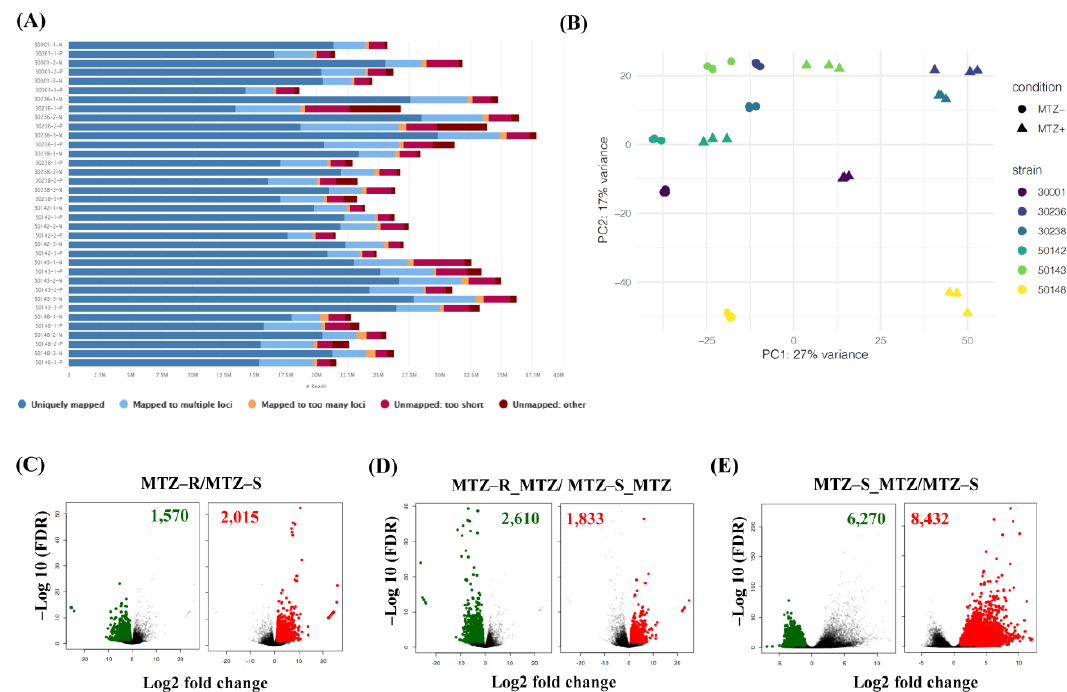
Figure 2. A global view of DEGs in the MTZ-R and MTZ-S transcriptomes treated with or without MTZ. ( A ) The reads generated from the RNA-seq data of six T. vaginalis isolates in the presence or absence of MTZ were mapped to the T. vaginalis reference genome, and the percentage of mapped reads was shown. ( B ) PCA of six isolates in the presence (MTZ+) or absence (MTZ-) of MTZ treatment. Biological triplicates of each sample were presented as different colors. Volcano plots showed the significantly differential gene expression (FDR < 0.05, log2 |fold change| = 1) in the MTZ-R transcriptomes compared with those of MTZ-S in the absence of MTZ (MTZ-R/MTZ-S) ( C ) or upon MTZ treatment (MTZ-R_MTZ/MTZ-S_MTZ) ( D ). ( E ) DEGs in the MTZ-S transcriptomes treated with MTZ was compared with those of MTZ-S (MTZ-S_MTZ/MTZ-S). The green and red dots represent the downregulated or upregulated genes in each group, respectively.